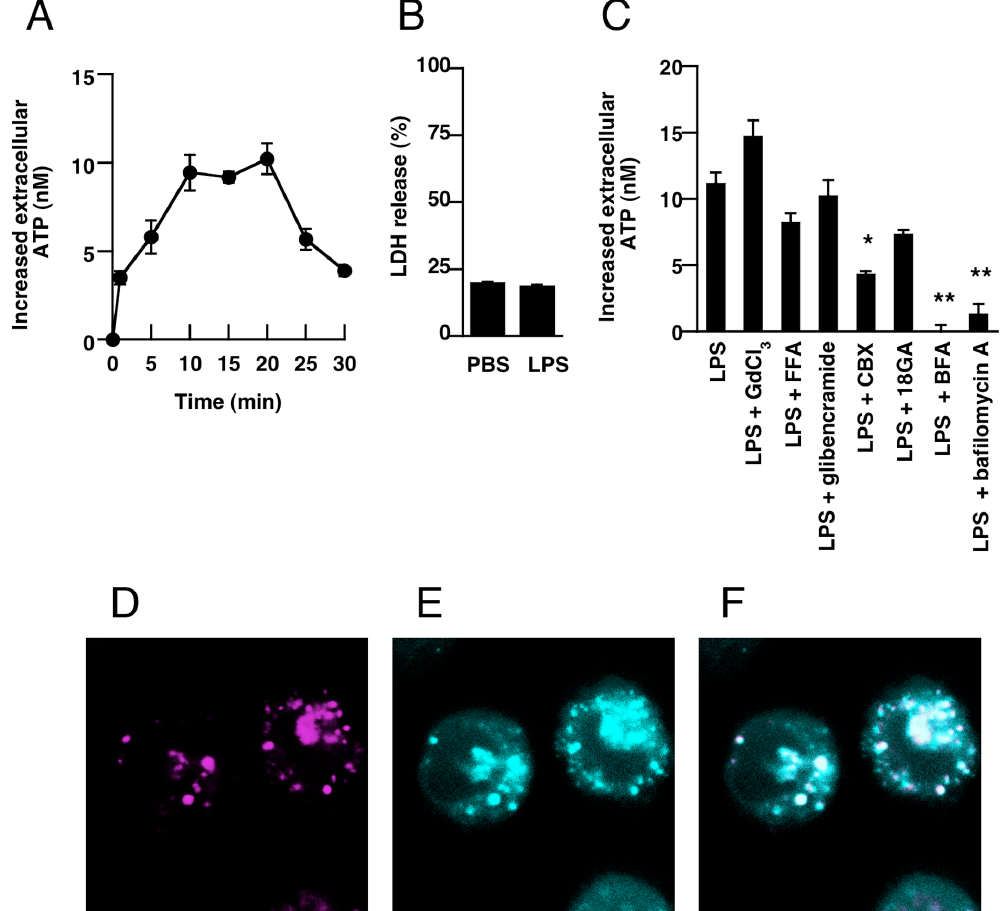
Figure 1. LPS-induced ATP release from THP-1 cells. ( A ) Cells were stimulated with LPS (10 m g/mL) and incubated for the indicated times, then the concentration of ATP in the culture medium was measured as described in Materials and Methods. ( B ) Cells were incubated with PBS or LPS for 30 min. At the end of incubation, supernatants were collected and LDH content was measured. The release of LDH is expressed as a percentage of total content determined by lysing an equal number of cells with 1% Triton X-100. ( C ) Cells were pretreated with GdCl 3 (100 m M), FFA (50 m M), glibenclamide (100 m M), CBX (50 m M), 18GA (50 m M), BFA (10 m M) or bafilomycin A (50 nM) for 30 min. At 10 min after LPS stimulation, supernatants were collected and ATP contents were measured. ( D–F ) Cells were stained with MANT-ATP (50 m M, cyan, panel C) and quinacrine dihydrochloride (5 m M, magenta, panel D) for 1 h at 37 u C. Then, stained cells were analyzed using a confocal laser scanning microscopy. The merged image is shown in panel E. Each value represents the mean 6 SE (n=4–8). Significant differences between the indicated groups and control group (LPS alone) are indicated by *(p , 0.05) and **(P , 0.01), respectively.